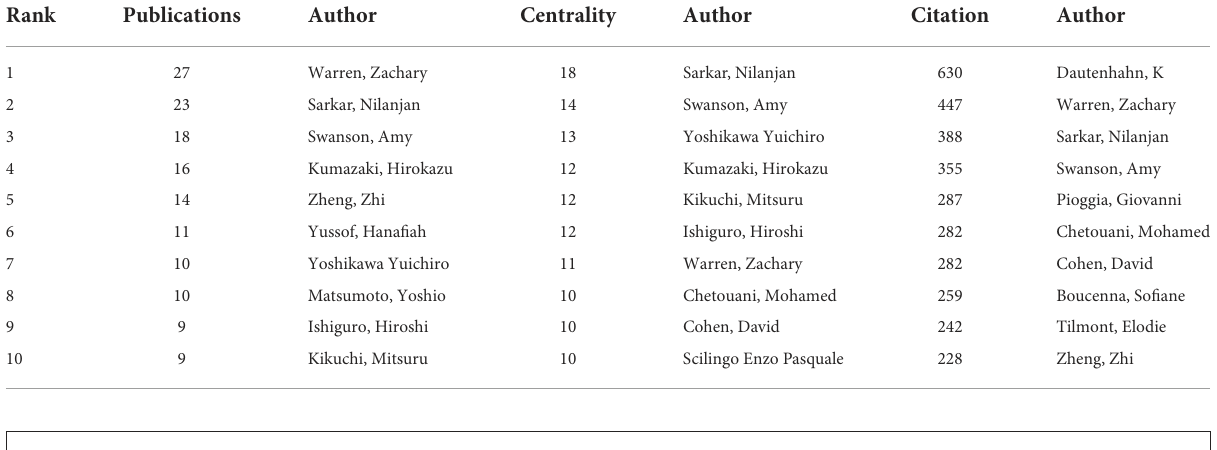
TABLE 5 Top 10 publications and centrality of authors related to AI on ASD.